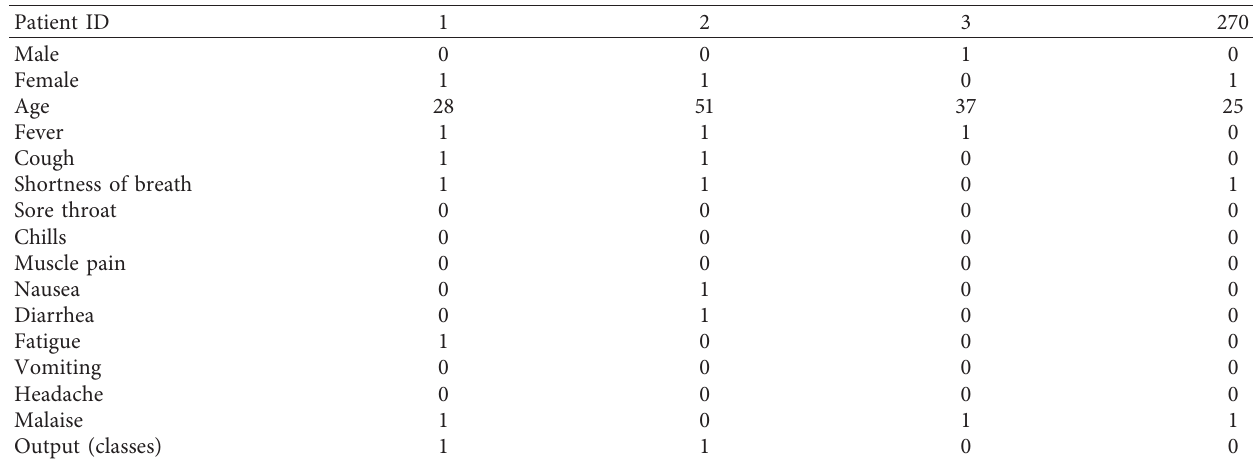
Figure 3: VGGNet model for COVID-19 diagnosis. Table 2: Symptoms